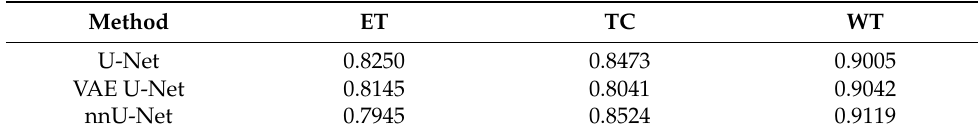
Table 1. Quantitative results of segmentation model on BraTS2018 dataset.